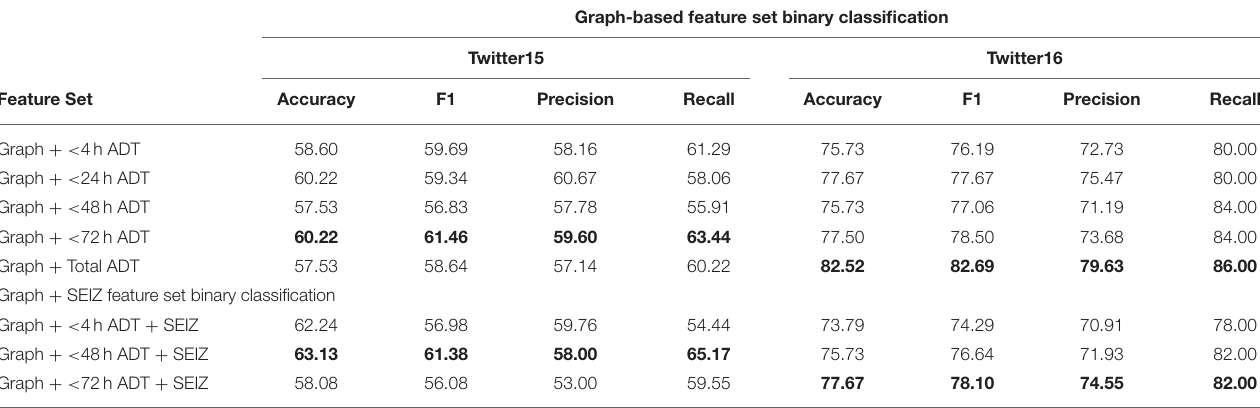
TABLE 6 | Twitter15 and 16 Graph-based and combined feature sets—binary classification results with labels = {true,